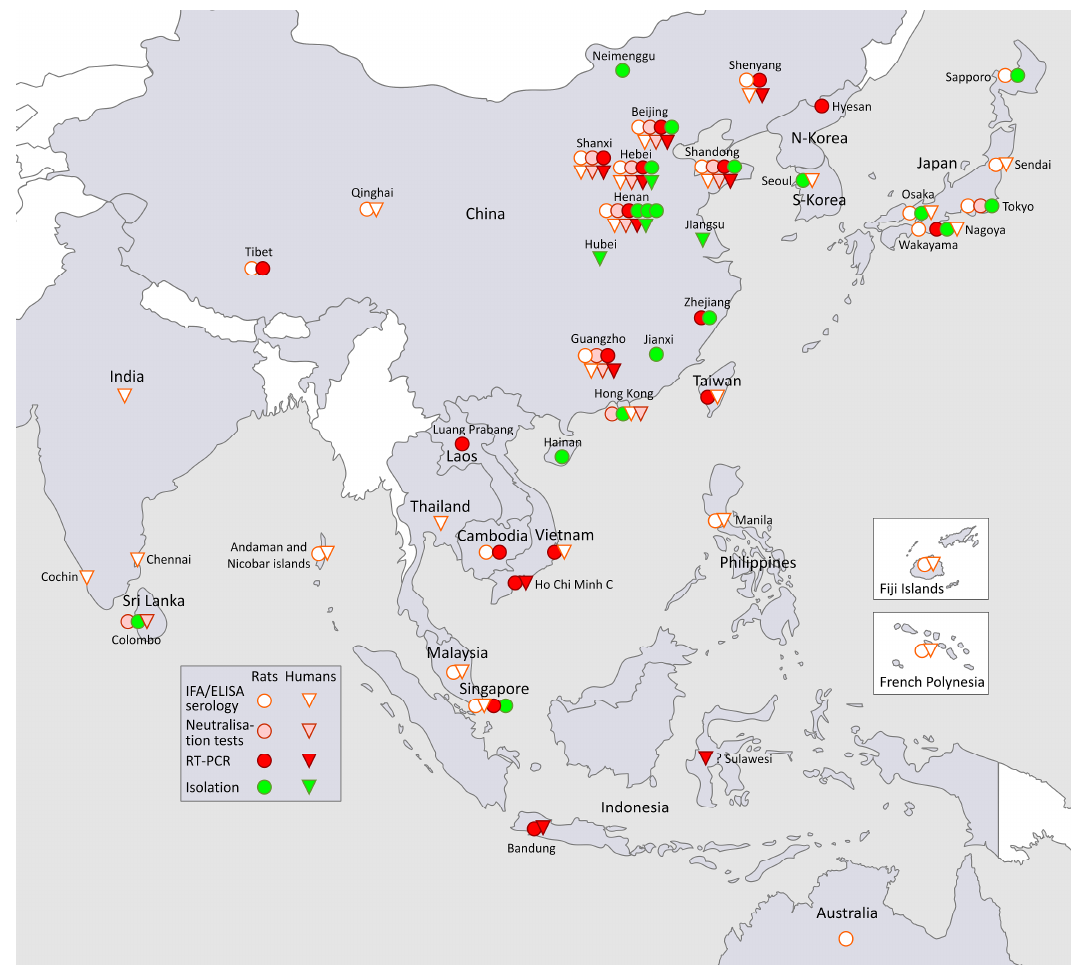
Figure 1. The map does not aspire to completeness and refers only to data given in the text. The first SEOV isolation occurred in 1980 in S. Korea [8], followed in 1982 by China [20], and in 1983 by Japan [21]. Whereas China su ff ered mixed HTNV-SEOV epidemics, involving thousands of